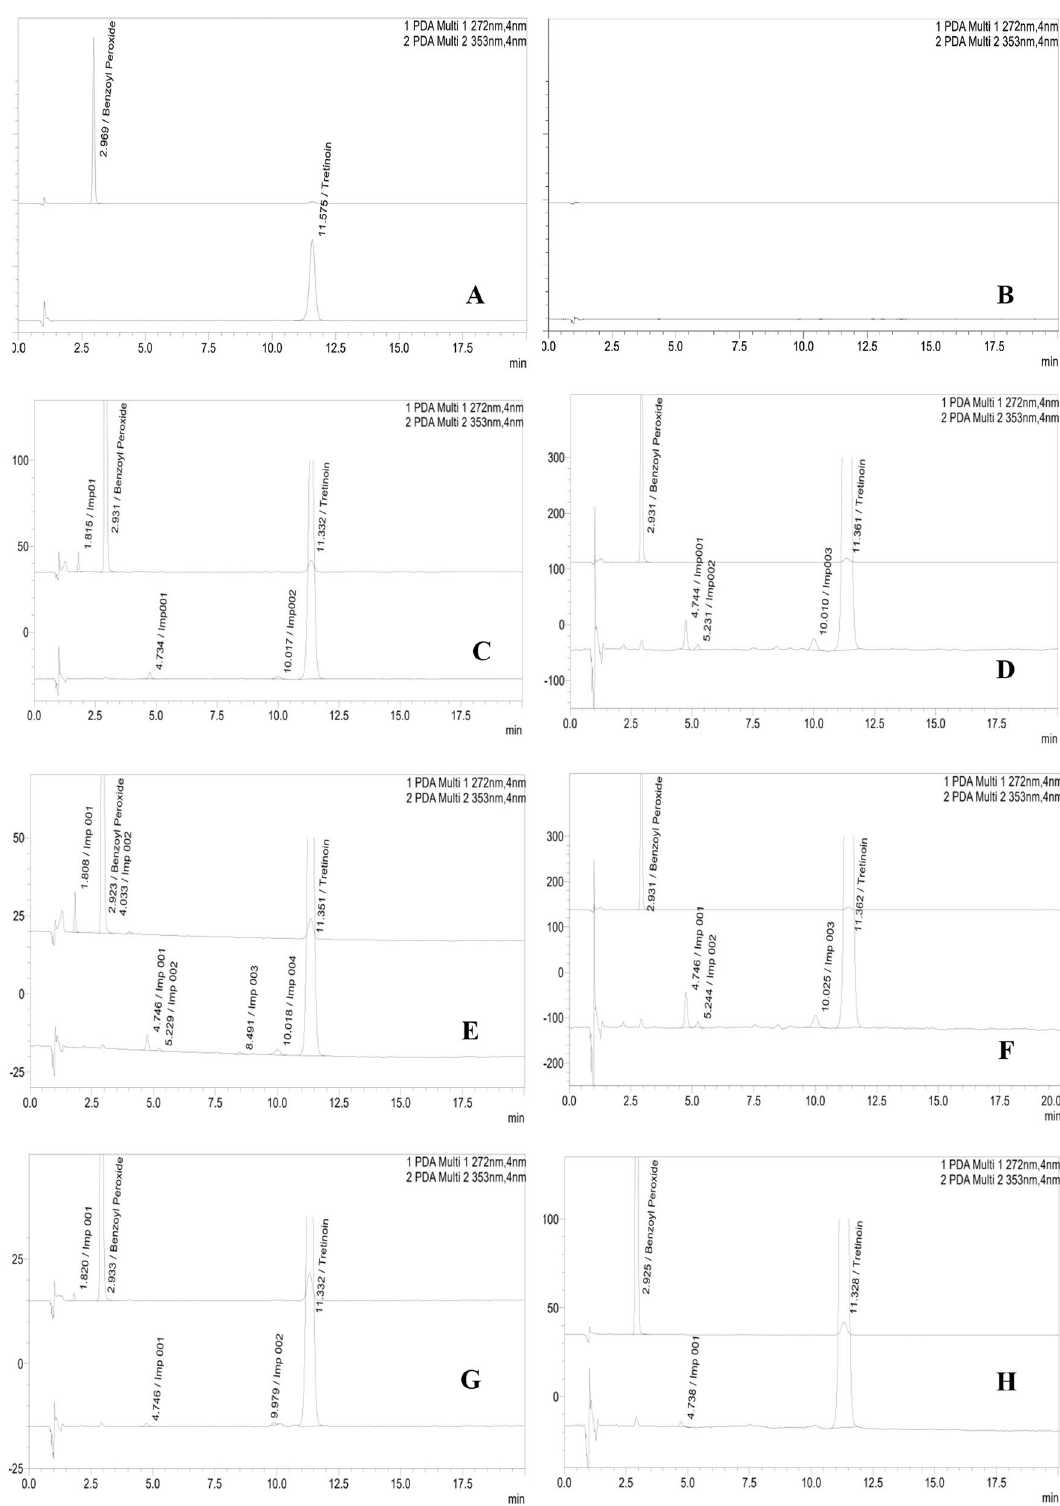
Fig. 3 Specificity chromatograms A standard solution, B Placebo solution, C acidic stress, D alkali stress, E oxidative stress, F photolytic stress, G thermal & humidity, H room